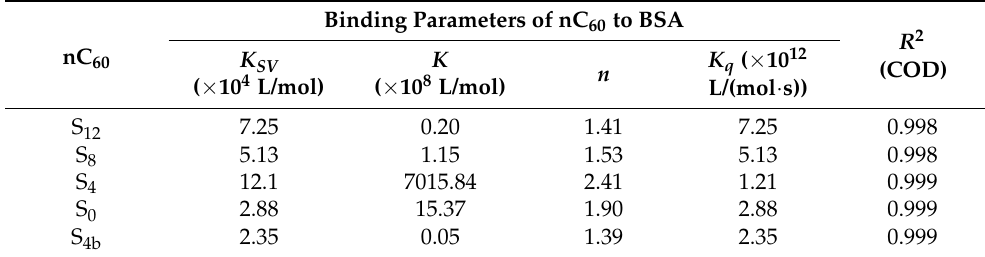
Table 1. The parameters ( K SV , K , n, and K q ) of the interaction between nC 60 and